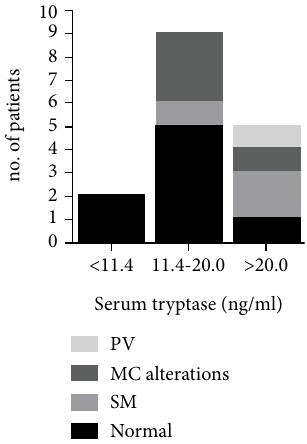
Figure 1: Bone marrow assessment results related to serum tryptase levels. MC: mastocyte cells; SM: systemic mastocytosis; PV: polycythemia